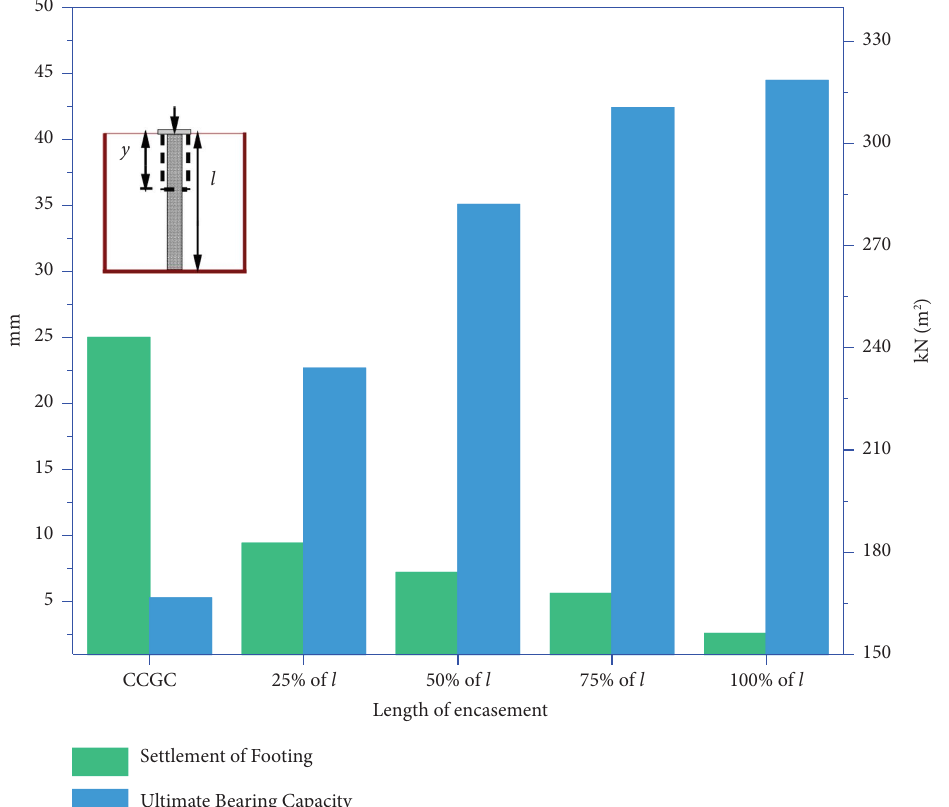
Figure 15: Efect of encasement length on ultimate bearing capacity–settlement relationship for improved soft